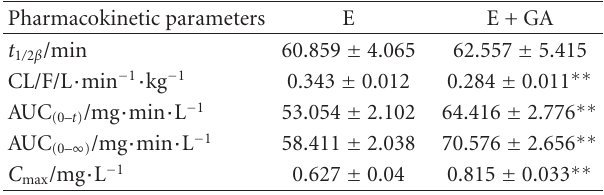
Table 2: The main pharmacokinetic parameters of cortisol in two groups n =